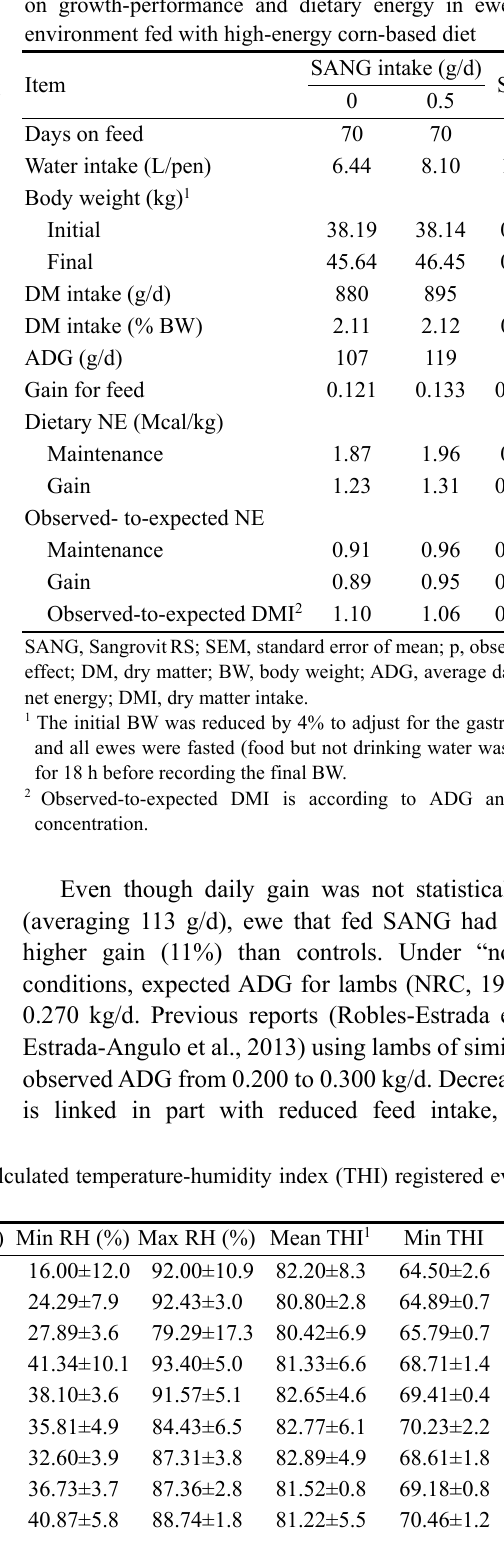
Table 3. Effects of Sangrovit-RS supplementation (0.5